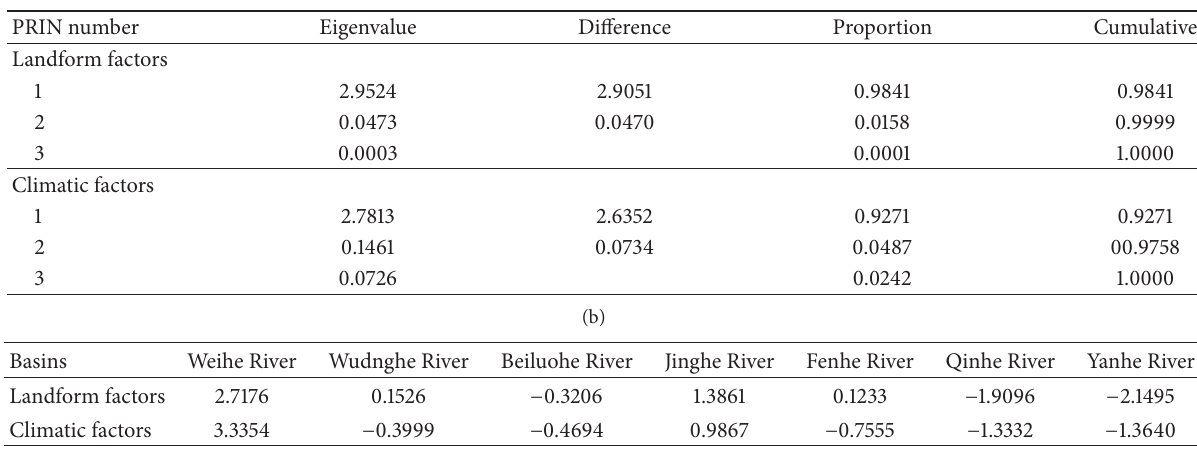
Table 2: The proportion of covariance and first principal values of landform and climatic factors.